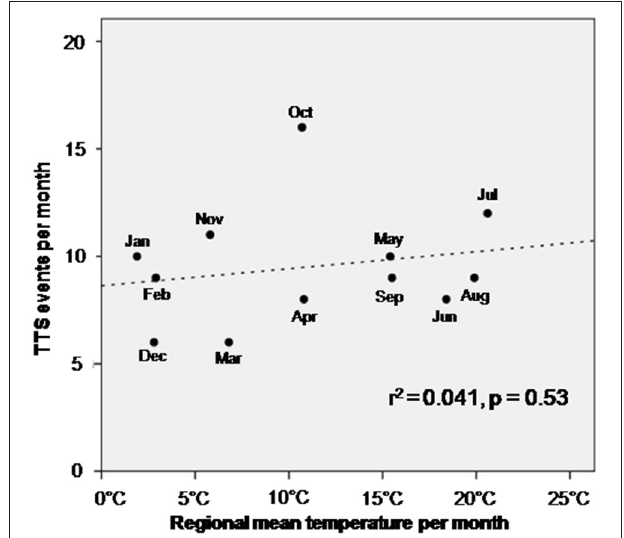
FIGURE 3 | Correlation of temperature per month with the incidence of TTS. No significant association has been observed.